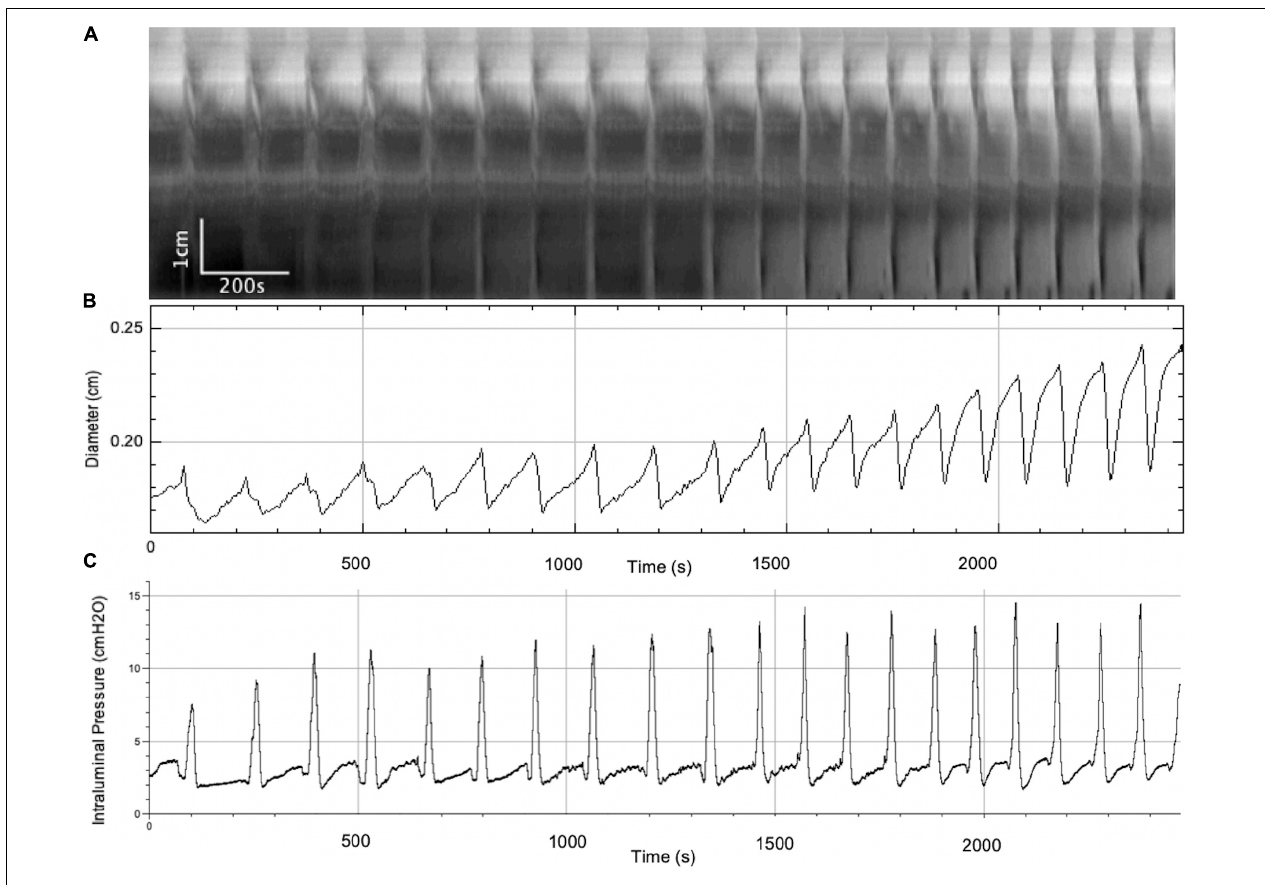
FIGURE 3 | A gradual increase in intraluminal pressure causes an increase in CMC frequency and the amplitude of accompanying phasic contractions, as well as intraluminal pressure changes. (A) Spatiotemporal map of CMCs. (B) Average diameter of the colon over time. (C) Intraluminal pressure in the colon over time.